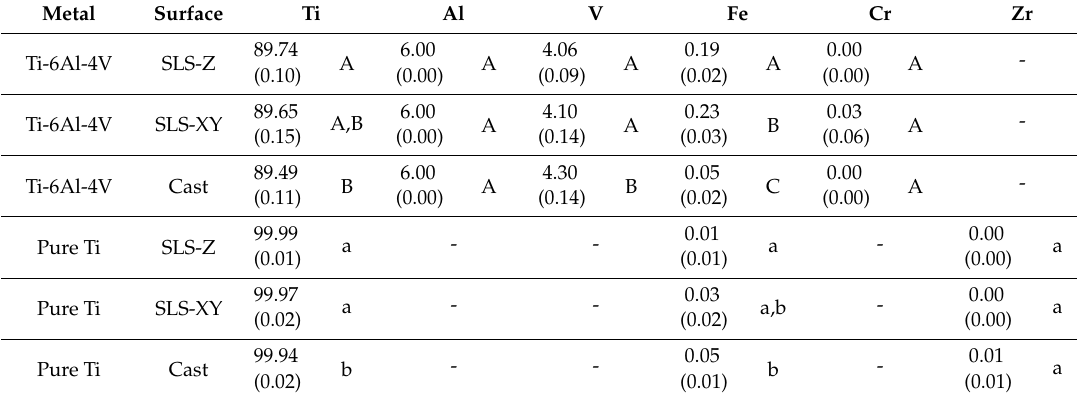
Table 4. X-ray fluorescence analysis of elements (%).